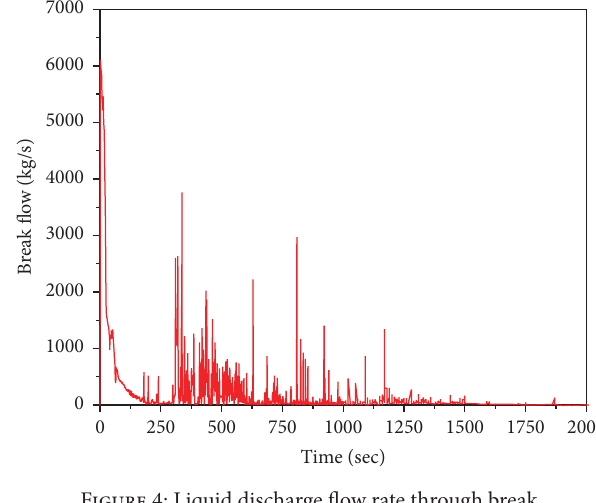
Figure 4: Liquid discharge flow rate through break.